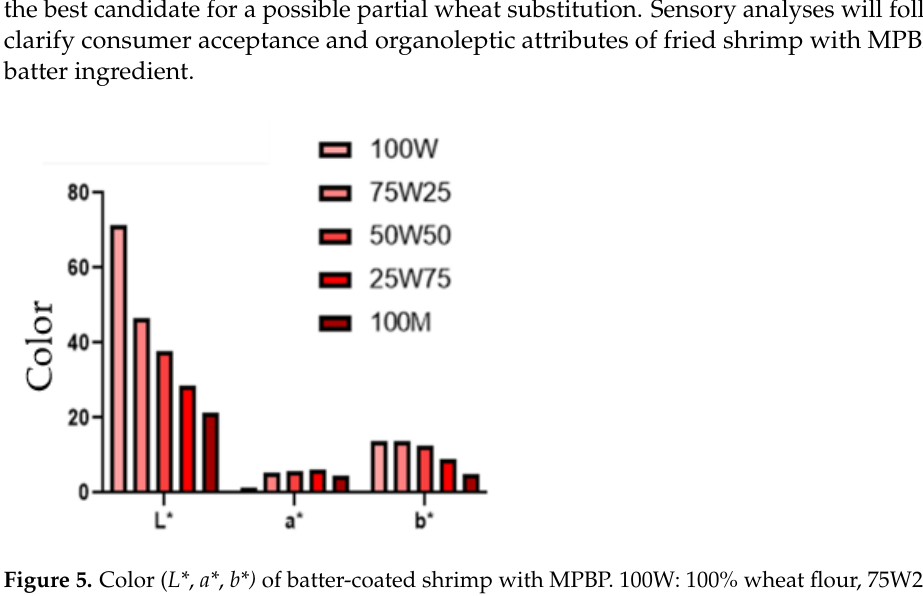
9 of 12 Figure 4. Coating of batter-coated shrimp with MPBP. 100 W: 100% wheat flour, 75 W25: 75% wheat flour and 25% MPBP, 50 W50: 50% wheat flour and 50% MPBP, 25 W75: 25% wheat flour and 75% MPBP, 100 M: 100. The error bars indicate standard division. ** p < 0.005, *** p < 0.0005. The frying process and the batter formulation influence the final color of a fried food p roduct. In this study, we standardized the frying process to evaluate the batter formula’s